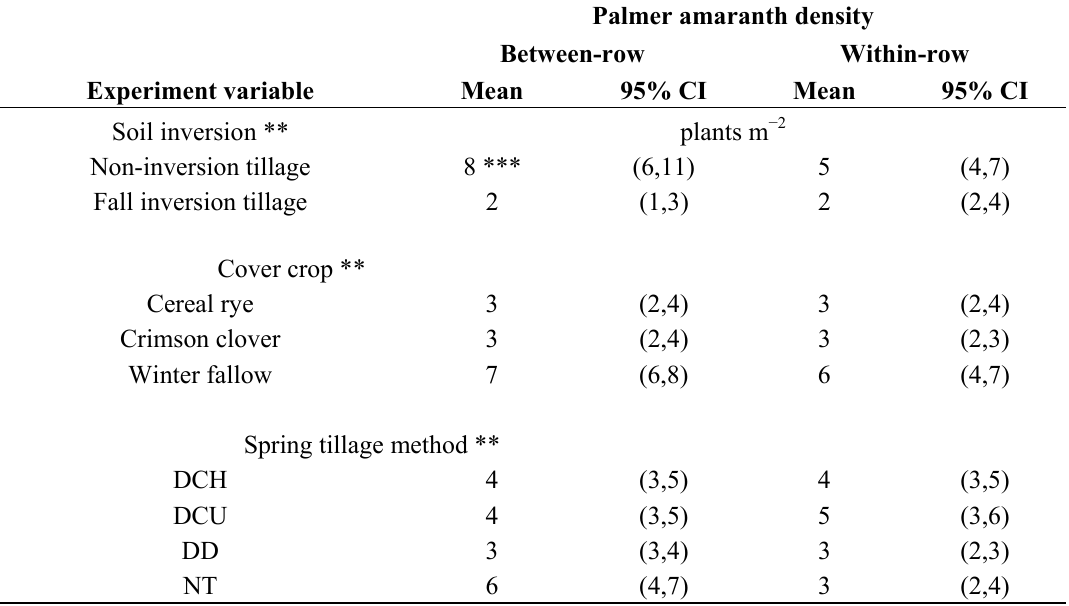
Table 2. Soil inversion, cover crop and spring tillage method means for between-row and within-row Palmer amaranth density at 2 WAP *; data combined over three production years. Palmer amaranth density Between-row Within-row Experiment variable